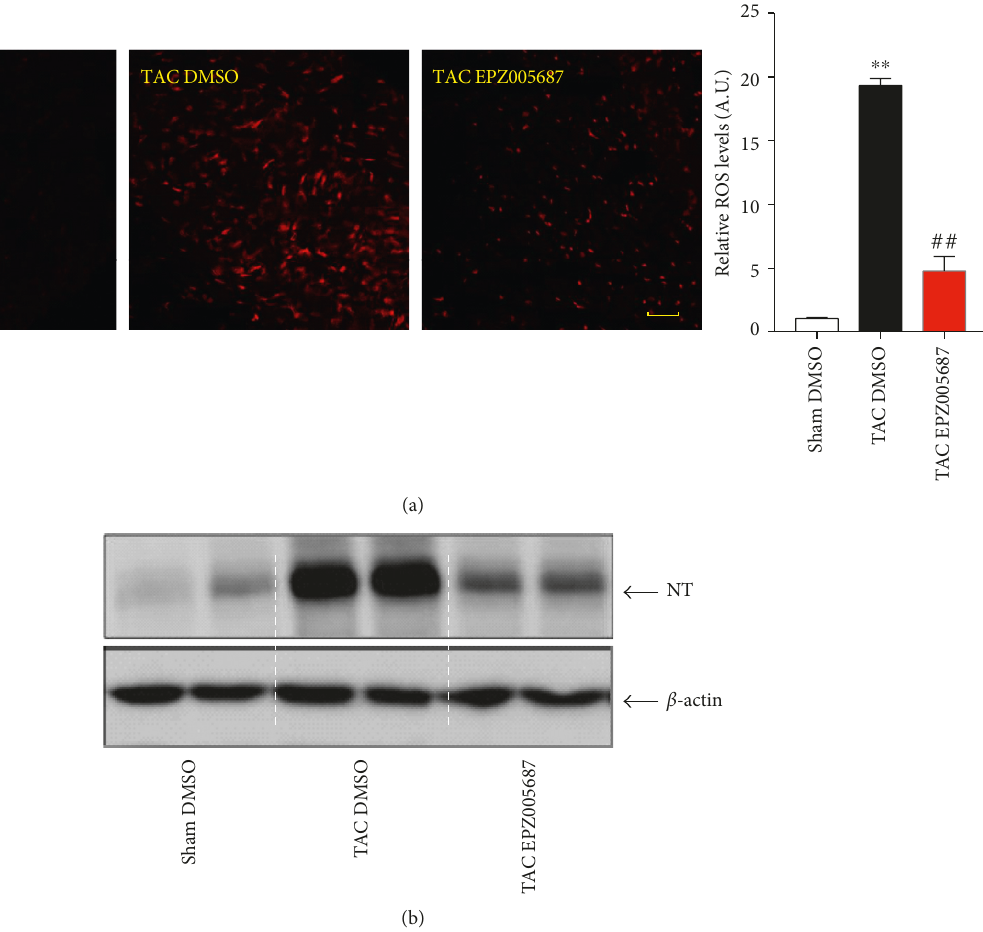
Figure 3: EPZ005687 treatment inhibits oxidative reactions in lungs in TAC-induced PAH mice. (a) Lung tissues ROS levels were evaluated by DHE staining (scale bar, 50 μ m, n � 5 for each group, ∗∗ P < 0 . 001 versus sham control, ## P < 0 . 001 versus TAC DMSO). (b) The expression of nitrotyrosine in lung lysate was detected by western